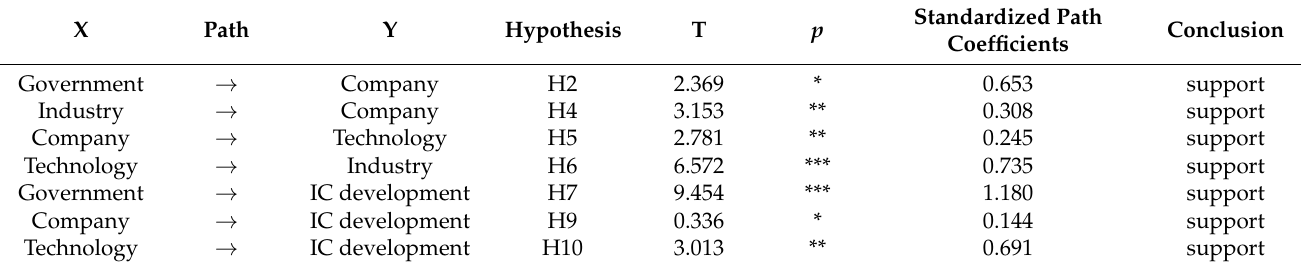
Table 8. Results of the model test.